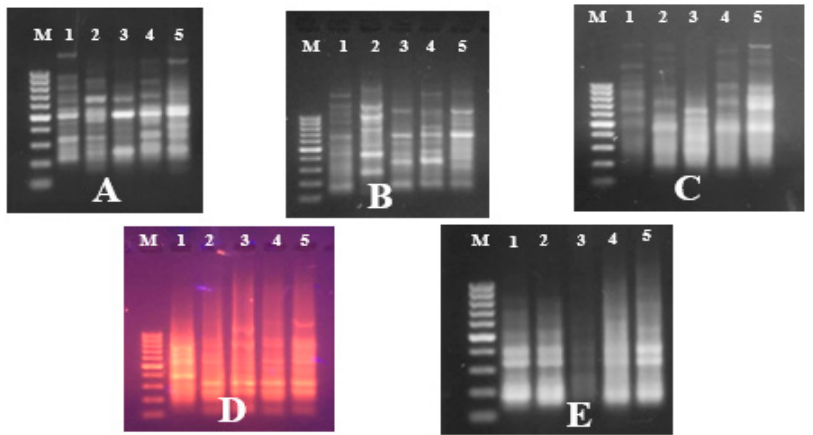
Figure 8. DNA fingerprinting of five RPW populations (1, Ismaeilia; 2, Qaluobia; 3, Arish; 4, Aswan and 5, New Valley) revealed from five ISSR markers: ( A ) BH9; ( B ) BH15; ( C ) BH10; ( D ) BH13; ( E ) BH8. Table 6. Specific markers for R. ferrugineus populations across ISSR-PCR analysis. Primer